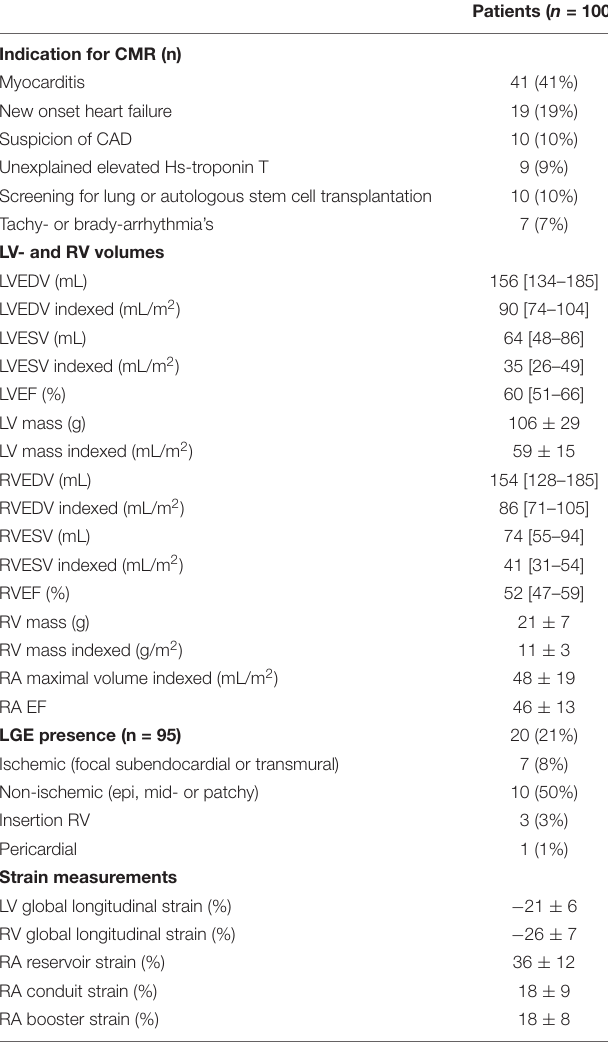
TABLE 2 | CMR characteristics of systemic sclerosis